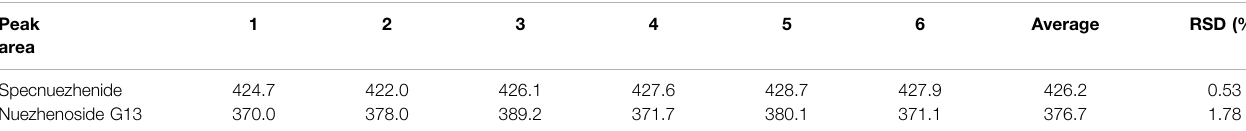
TABLE 2 | The precision test results of Specnuezhenide and Nuezhenoside G13.